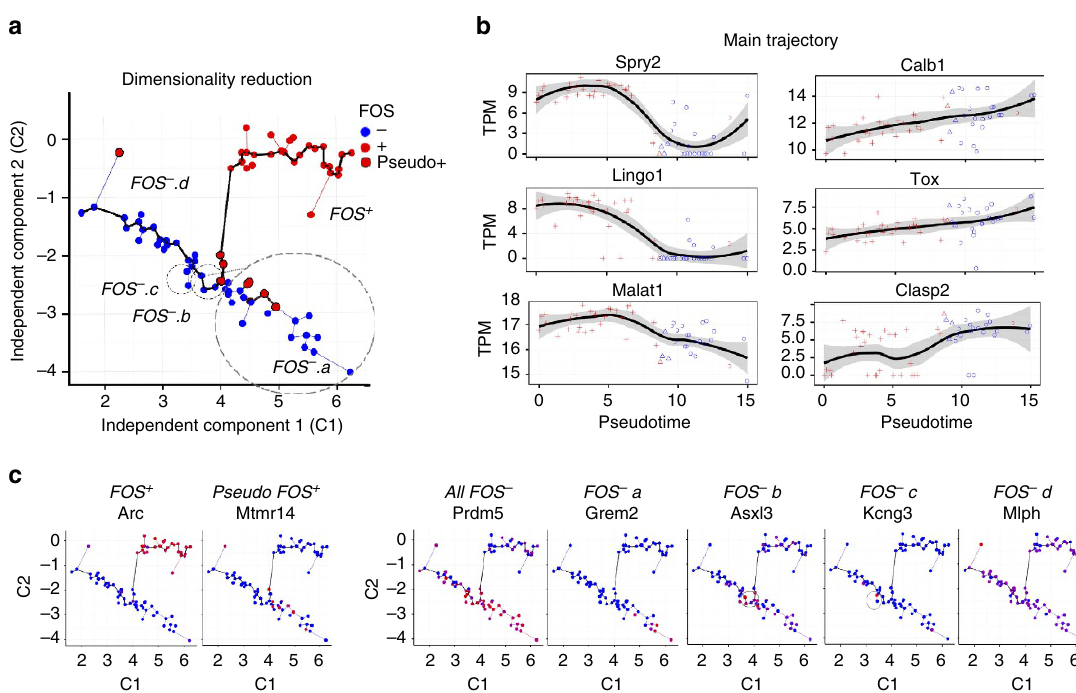
Figure 5 | NE nuclei exist along a continuum of transcriptional states. ( a ) Independent components based on analysis using Monocle with individual nuclei coloured by FOS protein staining. Pseudo-FOS þ nuclei (red with black outline) segregate towards the border of FOS þ (red) and FOS (cid:2) (blue) nuclei. ( b ) The top genes associated with pseudotime exhibit continuous patterns of expression linking FOS þ (red) and FOS (cid:2) nuclei (blue). ( c ) Expression based on cluster, high expression ¼ red, low expression ¼